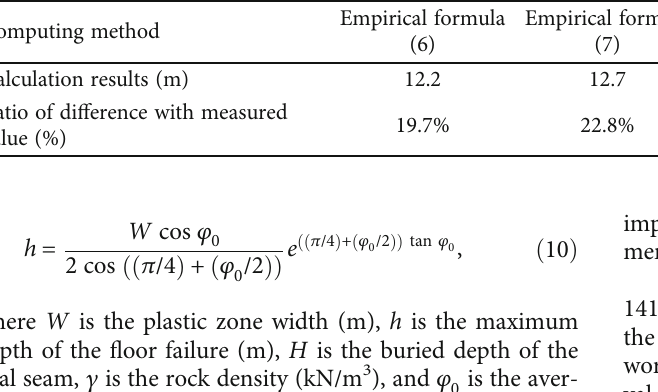
Figure 20: Determination of the parameters of the maximum failure depth. Table 6: Comparison of fl oor failure